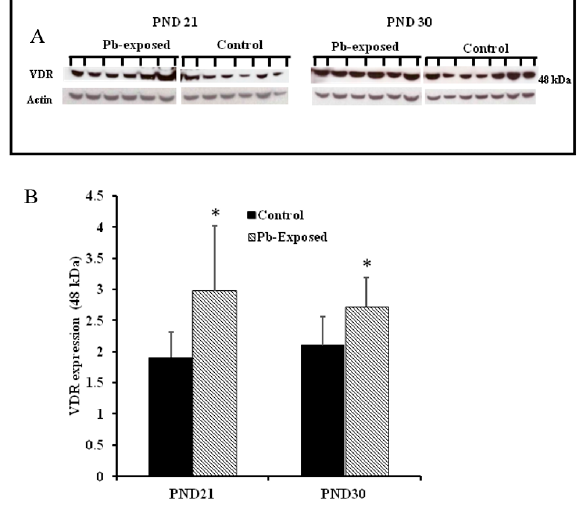
Figure 8. Effect of Pb exposure on VDR expression in the brain of Wistar rat pups : ( A ) Western blot analysis of brain tissue of control and Pb-exposed rats with VDR antibody at PND21 and PND30: 20 μ g of brain lysate was resolved on 10% SDS-PAGE and immunoblotted with antibody to VDR. For loading control, the same membranes were stripped and re-probed with anti-actin antibody; ( B ) Quantification of Western blot bands at 48 kDa for VDR on the blots (shown in A): Blots (both VDR and actin) were scanned and the band densities quantified with Syngene gene tool software. Signal for VDR was normalized to signal for β -actin (loading control). Data are presented as Mean ± SD ( n = 7). * Significantly different from control ( p < 0.05).